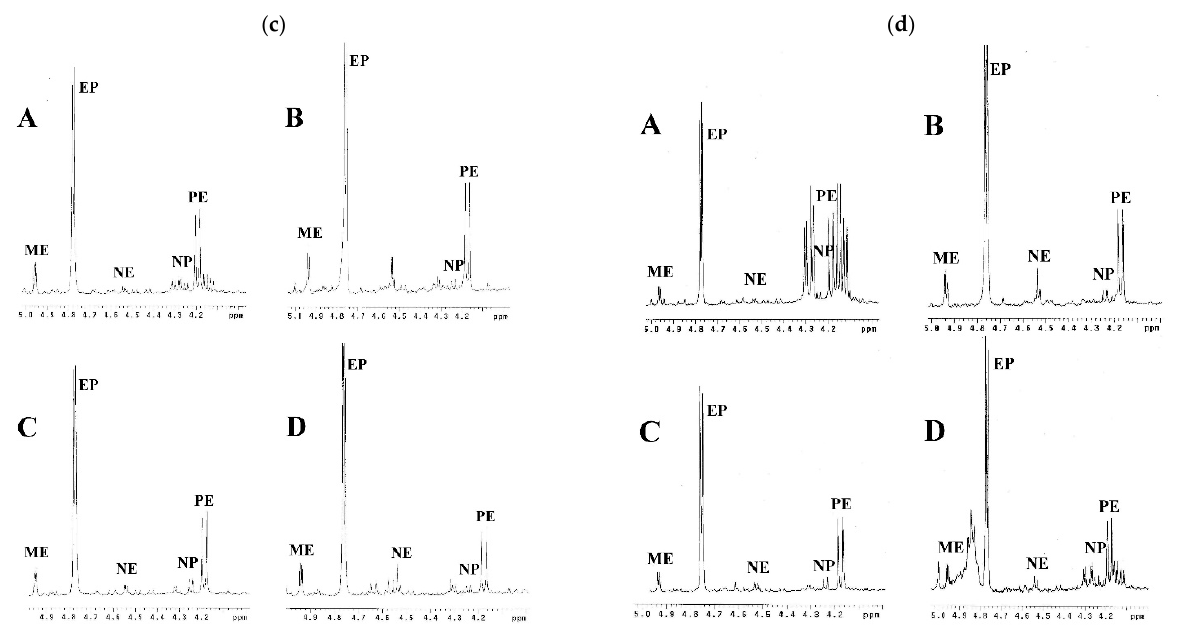
Figure 4. 1 H-NMR spectra of the Ephedra commercial prescriptions in the range of δ 4.0~5.0 ppm. ( a ) Ding Chuan Tang, ( b ) Shern Mih Tang, ( c ) Ma Huang Tang, and ( d ) Ma Xing Yin Gan Tang. A~D: Samples from companies A~D.